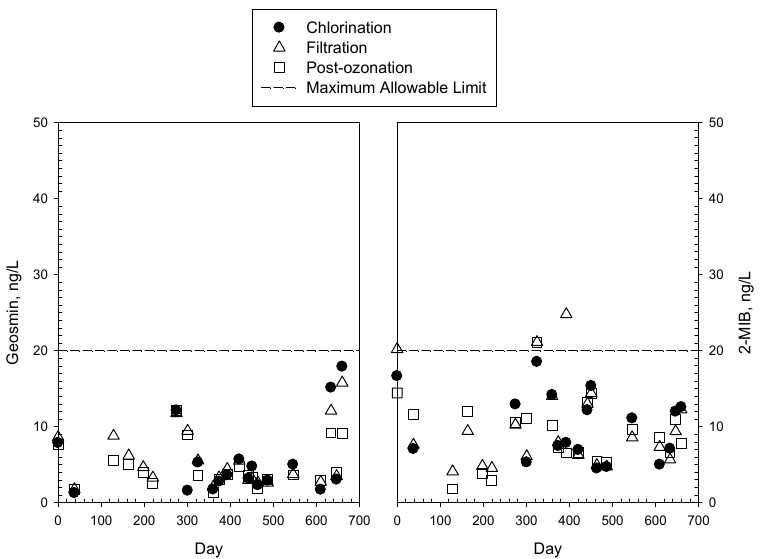
Figure 5. Concentrations of geosmin and 2-MIB affected by the filtration and postozonation pro- cesses.